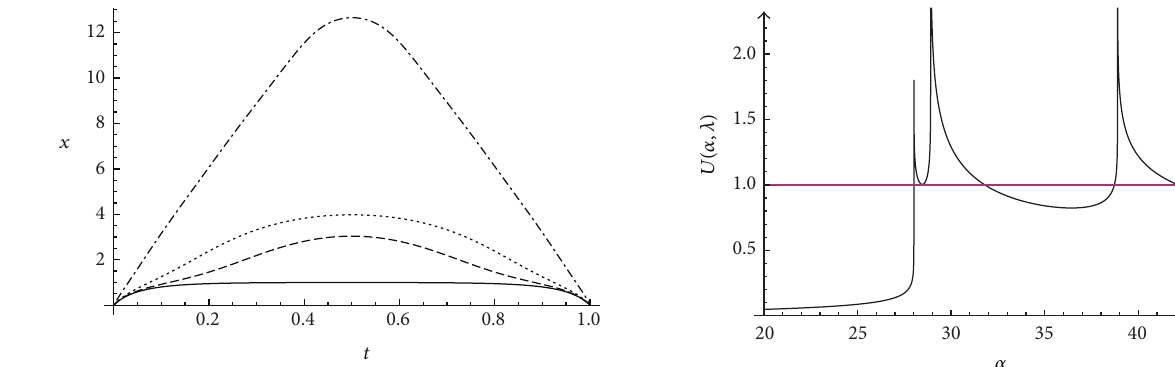
Figure 15: The graph of the function 𝑈(𝛼,0.02711) .